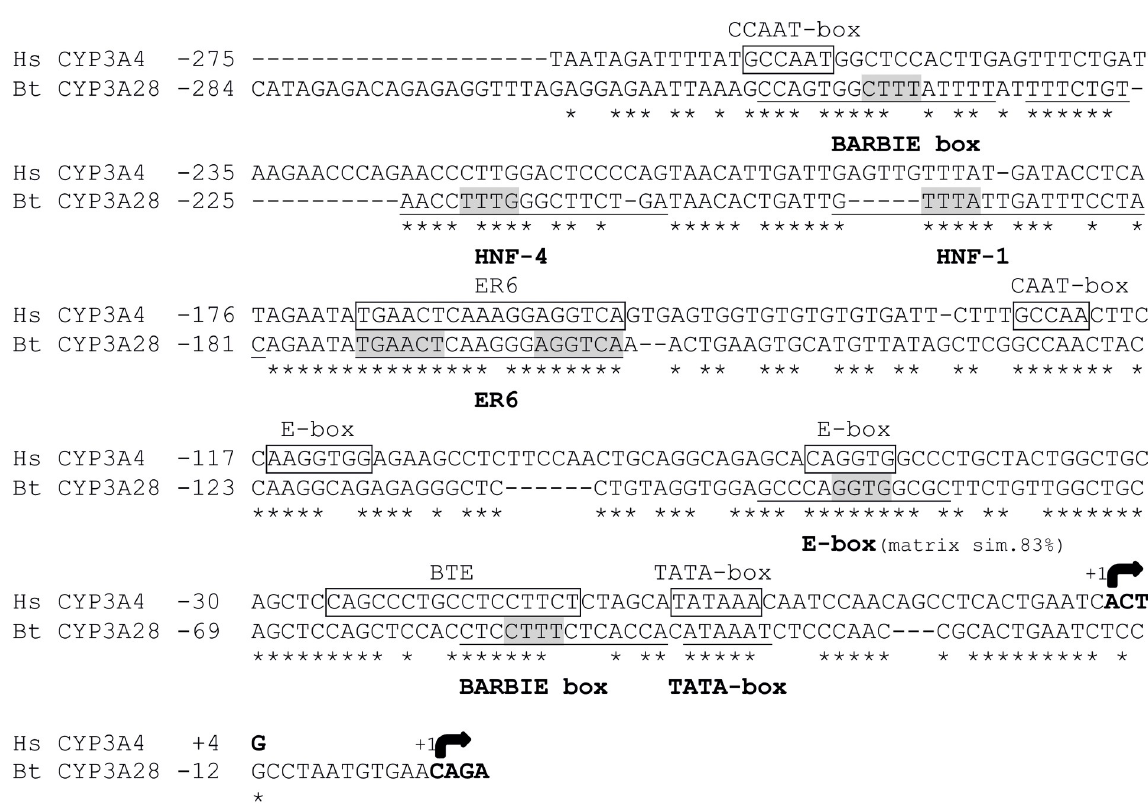
Fig 1. Sequence comparison and distribution of regulatory elements in the human CYP3A4 and bovine CYP3A28 proximal promoters. Identical nucleotides are denoted by asterisks. The transcription start sites are indicated by arrows. The sequence is numbered relative to the transcription start site taken as +1. The binding sites previously characterized in human proximal promoter are boxed (modified from [45]), the newly identified bovine elements are bolded and underlined. For the elements identified through MatInspector analysis, the nucleotides matching the matrix core are highlighted in grey